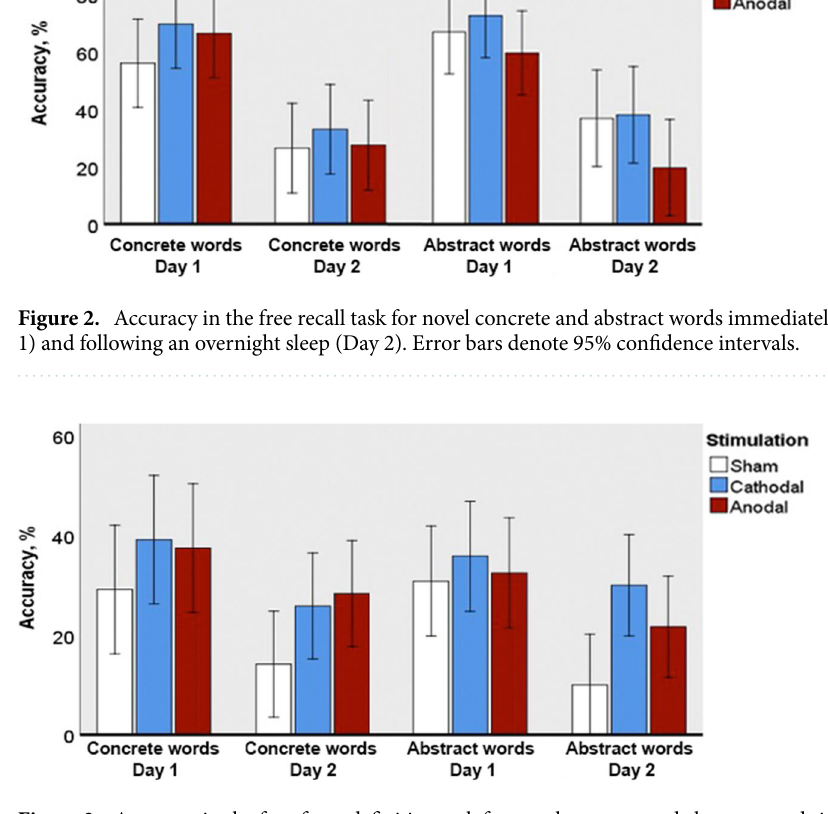
Figure 3. Accuracy in the free-form definition task for novel concrete and abstract words immediately after learning (Day 1) and following an overnight sleep (Day 2). Error bars denote 95% confidence intervals.